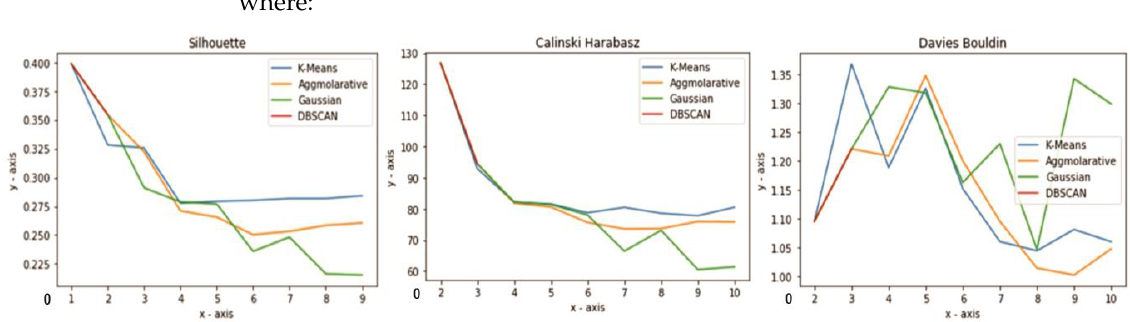
Figure 2. Silhouette coefficient, Calinsky–Harabasz, and Davies–Bouldin distribution on clusters for different algorithms.